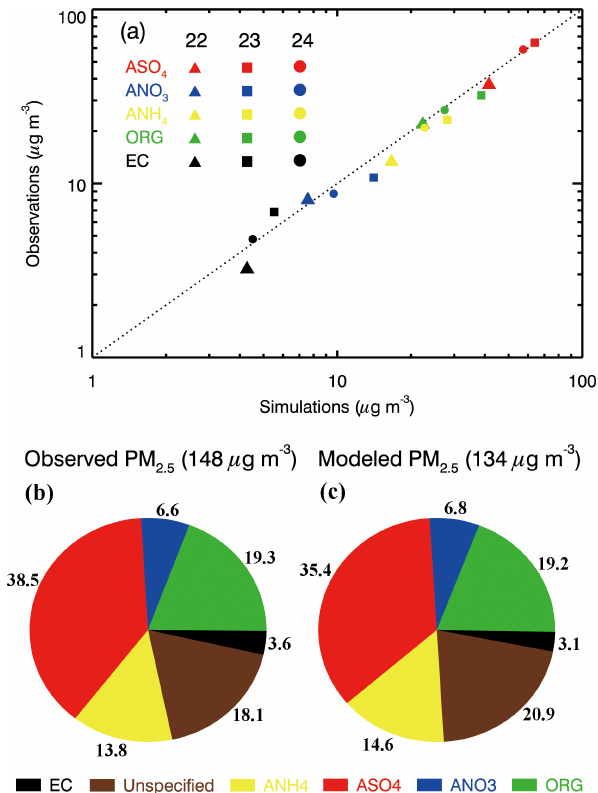
Figure 11. Panel (a) : scatterplot of measured daily aerosol con- stituents with simulations and comparison of (b) measured and (c) modeled PM 2 . 5 chemical composition